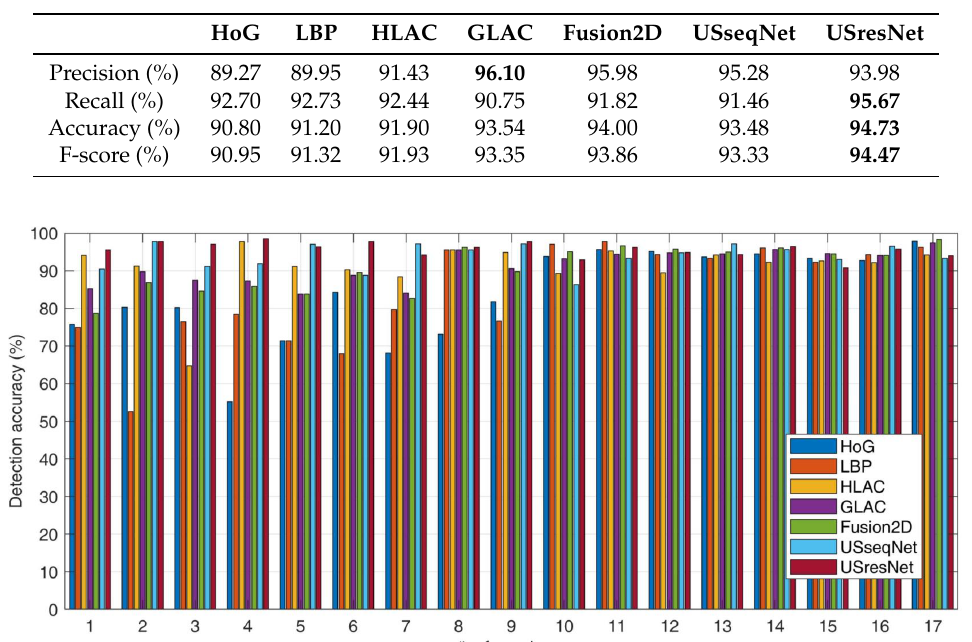
Table 4. Results of automatic ultrasonic image pattern classification using various methods. The bold figures denote optimal results under evaluation criteria.